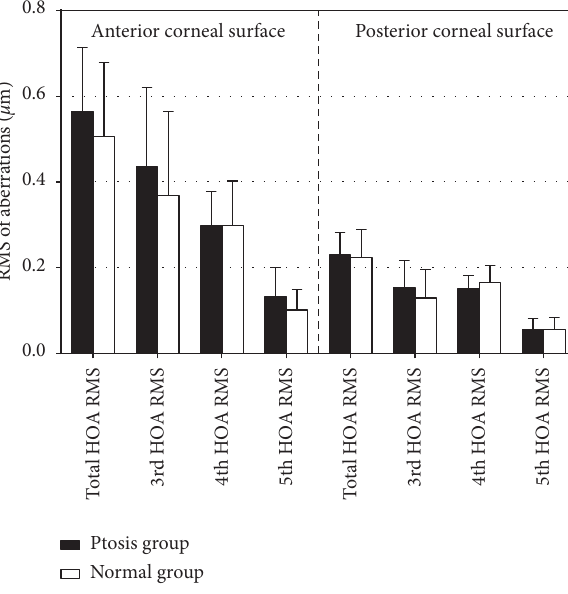
Figure 2: Comparisons of the total and third-order to five-order higher-order aberrations (RMS HOAs) of the anterior and pos- terior corneal surface between the ptosis group and the normal fellow group. ∗ p < 0 .